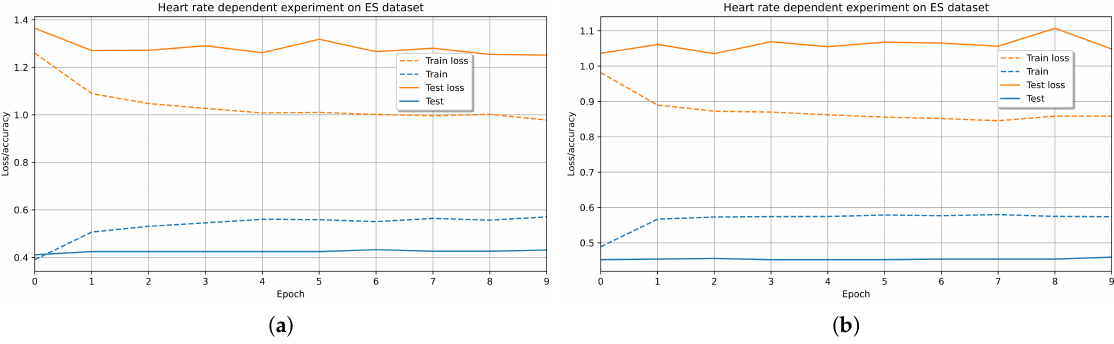
Figure 11. Training and validation of the 1D CNN LSTM model in the Emotional Slices (ES) dataset. The accuracy outcomes correspond to the classification of: ( a ) four emotional quadrants in Table 4; ( b ) three emotional quadrants in Table